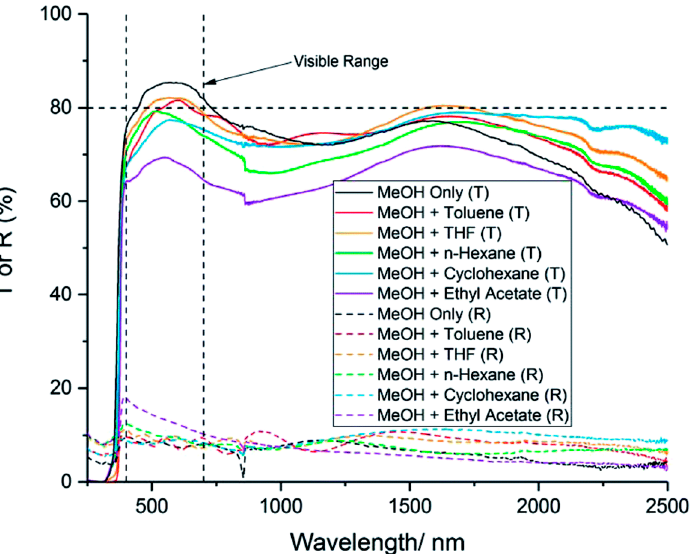
Figure 6. Transmission–reflectance spectra for 10 mol% AZO deposited via AACVD using different solvents. “T or R” refer to transmission or reflectance. Reproduced with permission from ref. [64].